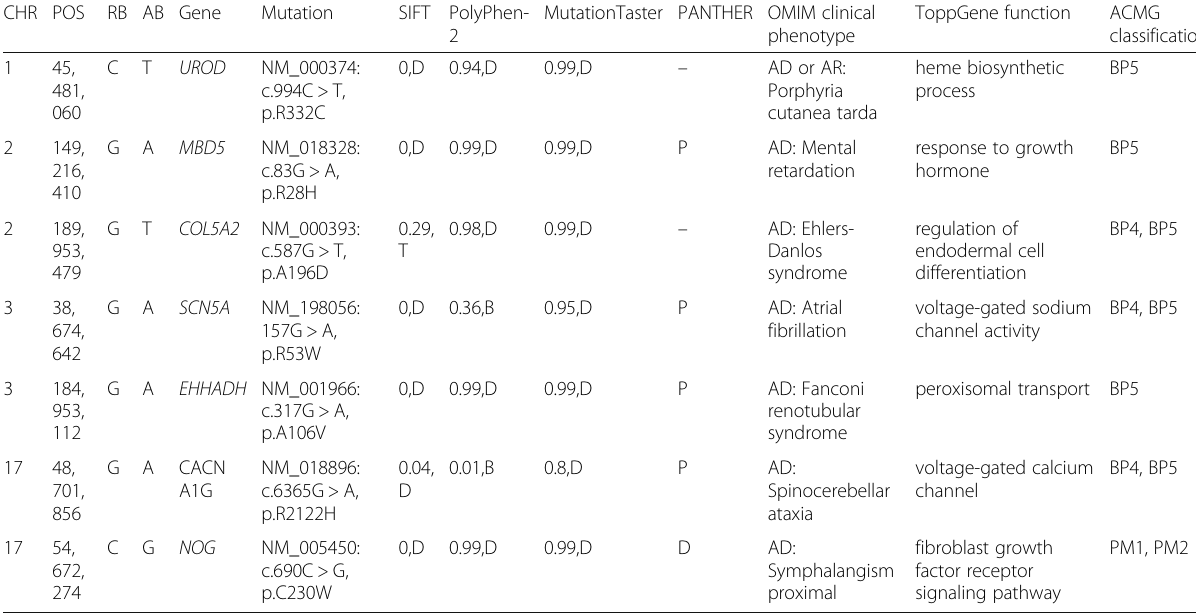
Table 1 The mutations list after data filtering and co-segregation analysis CHR POS RB AB Gene Mutation SIFT PolyPhen-